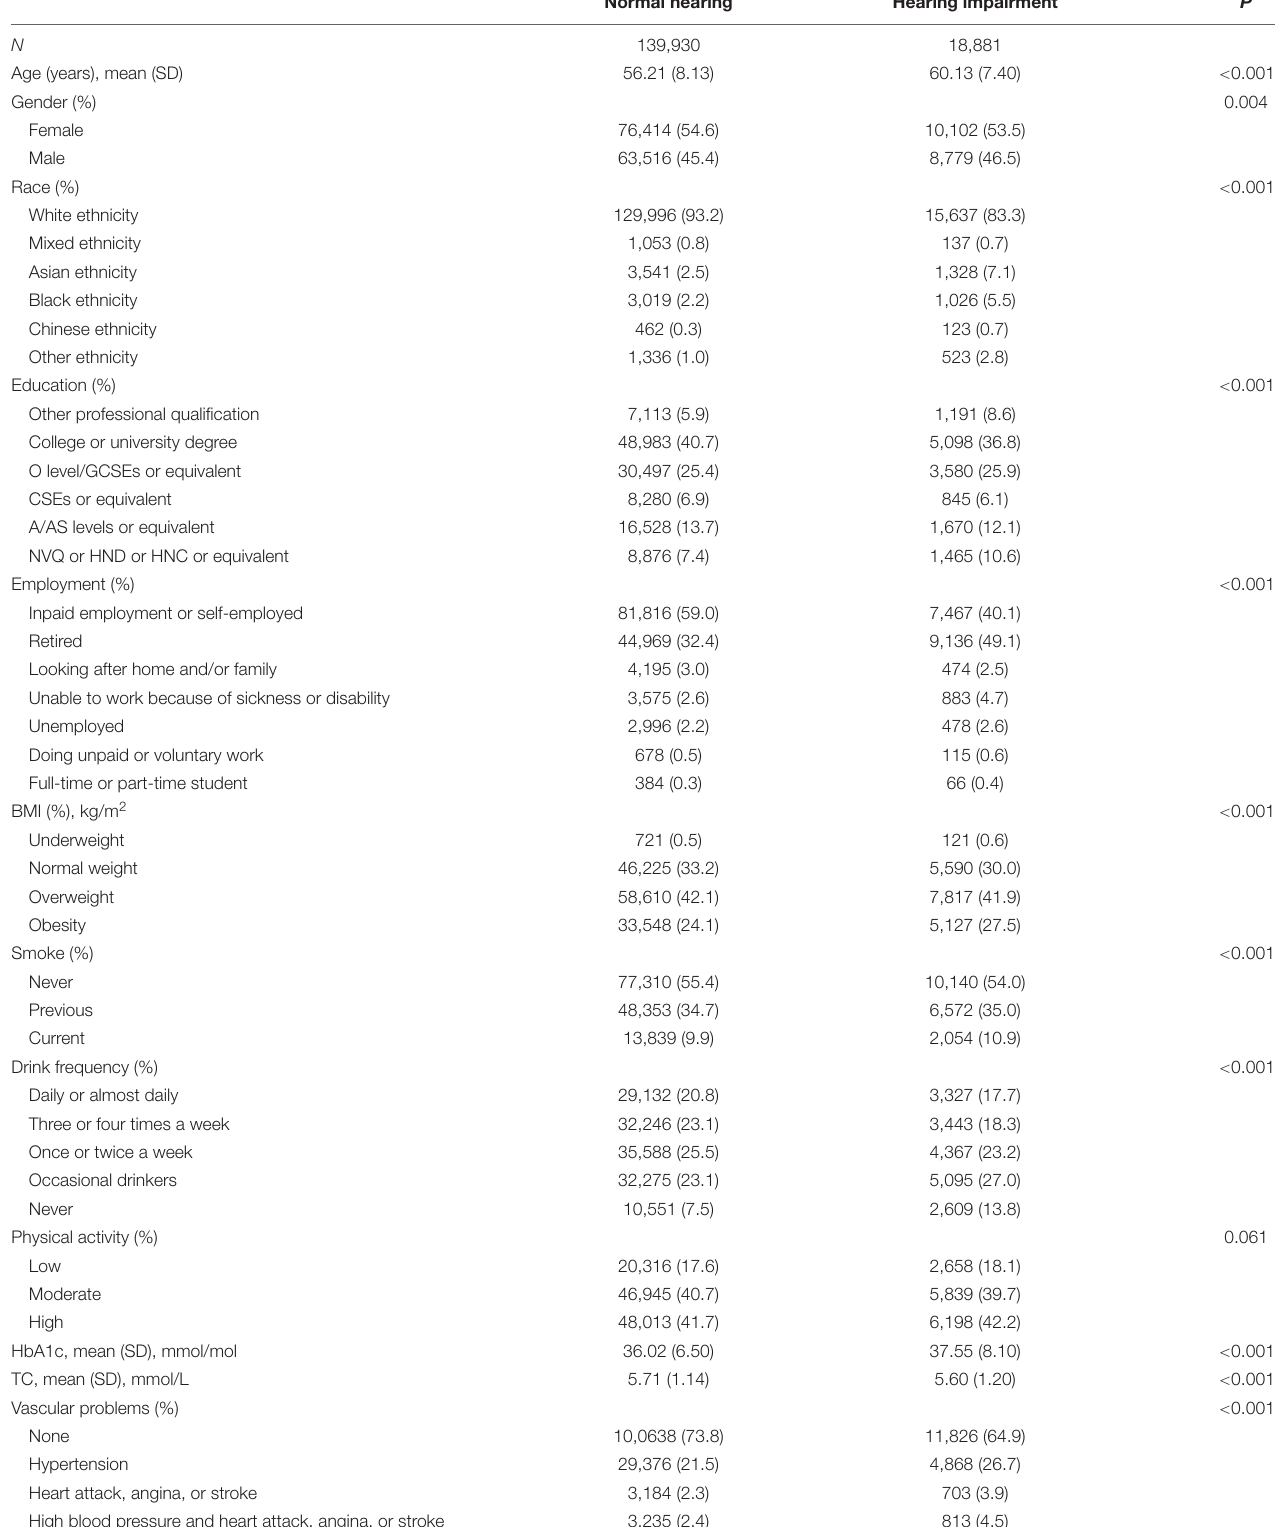
TABLE 1 | Characteristics of participants ( N =